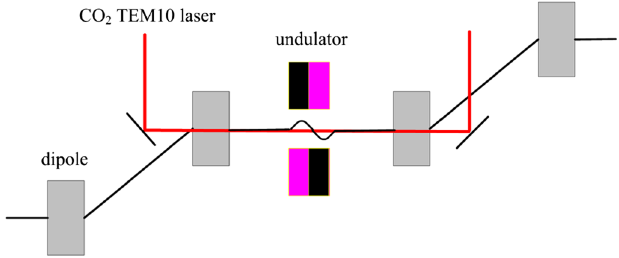
FIG. 1. (Color) Schematic of the laser assisted emittance